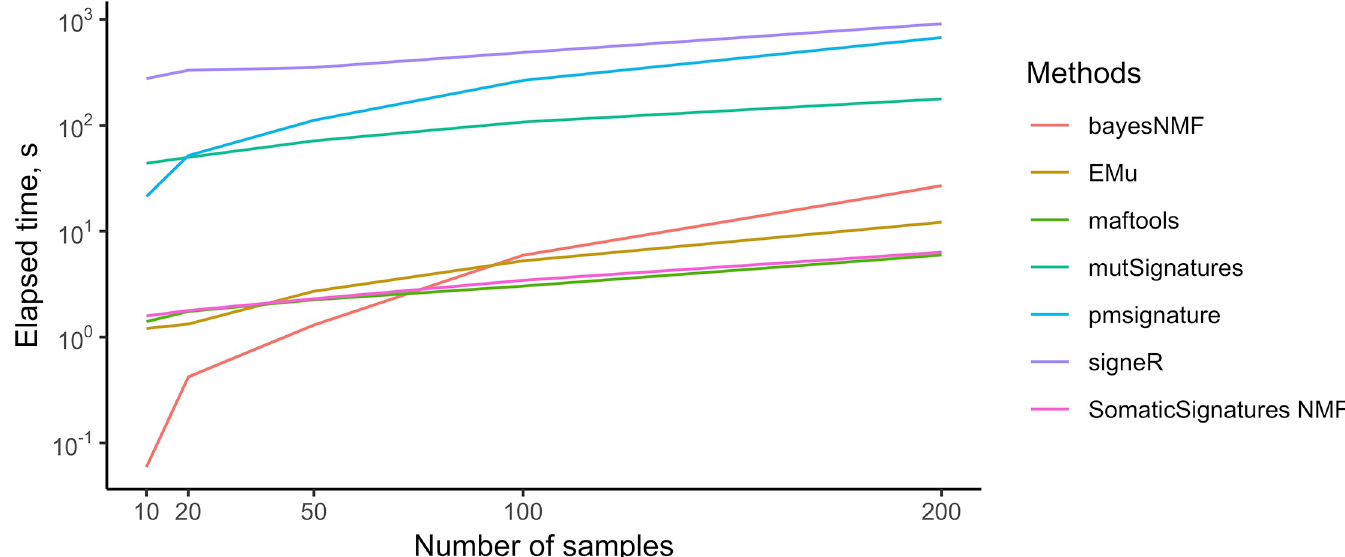
Fig 8. Running times of refitting tools. Methods were applied to subsets of the TCGA Lung cohort of different sizes. The y-axis is in logarithmic scale.